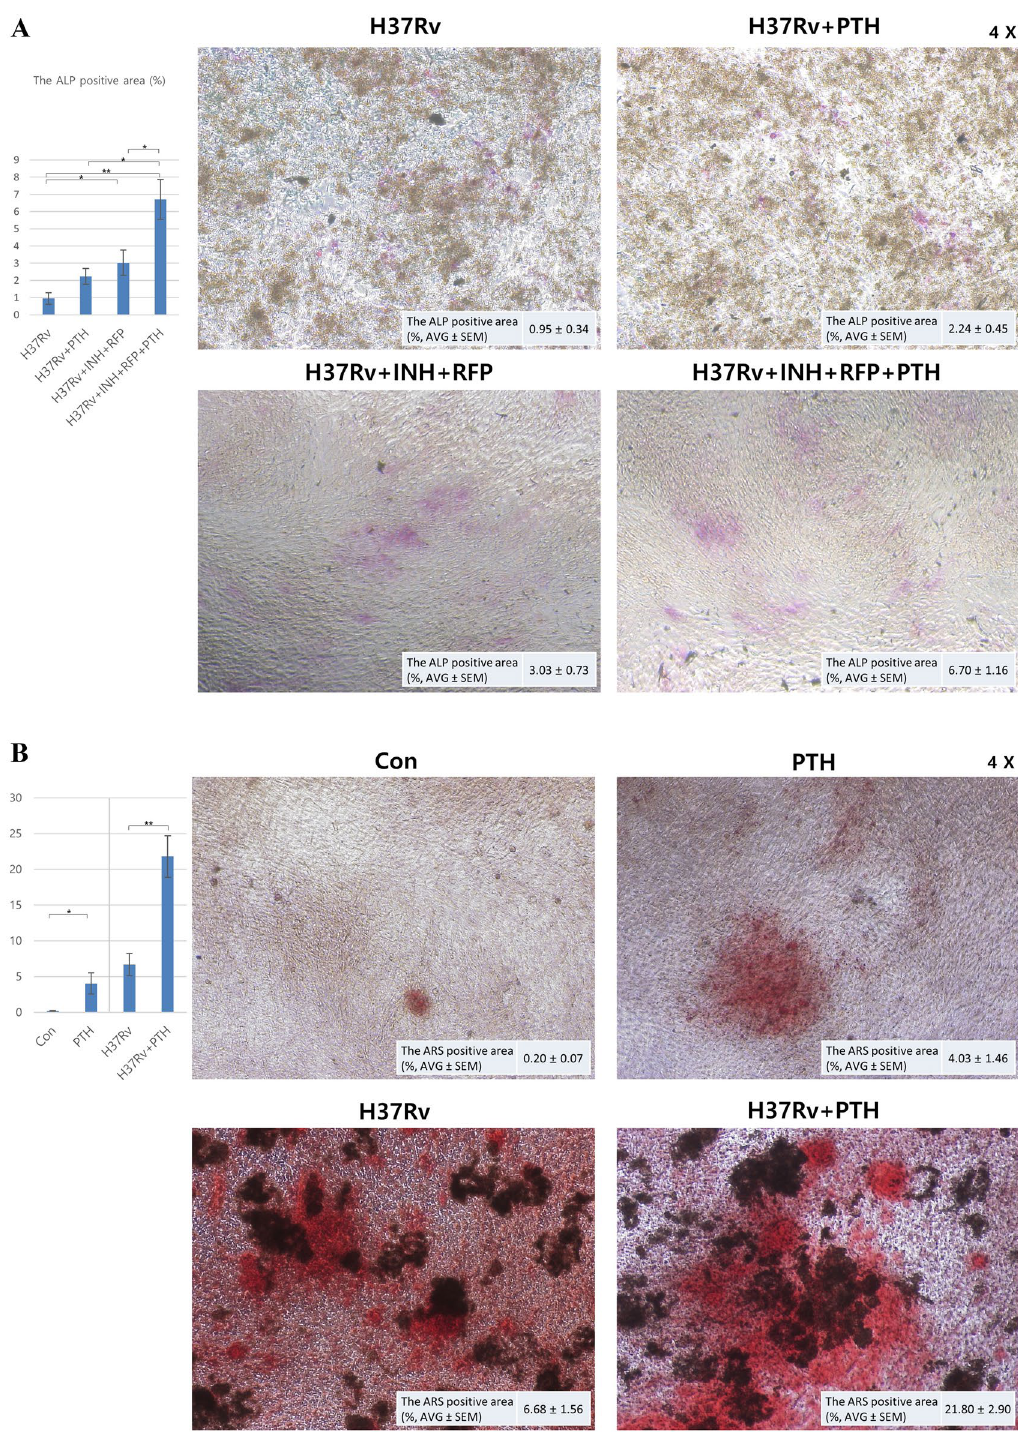
Figure 3. Alkaline phosphatase (ALP) and alizarin red S (ARS). ( A ) ALP- and ( B ) ARS-positive area was measured using bioquantification software (Bioquant Osteo II, R&M Biometrics, Nashville, TN, USA), and graphs show comparison of positive area for each group. Abbreviations: AVG, average; Con, control; INH, isoniazid; PTH, teriparatide; RFP, rifampin; SEM, standard error of mean; * P < 0.05; **, P <